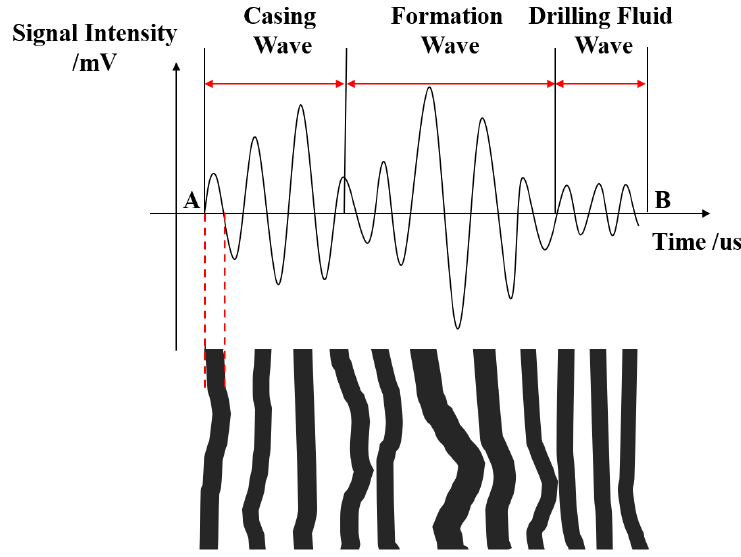
Figure 2. Waveform chart of full wave train of VDL. (1) Free